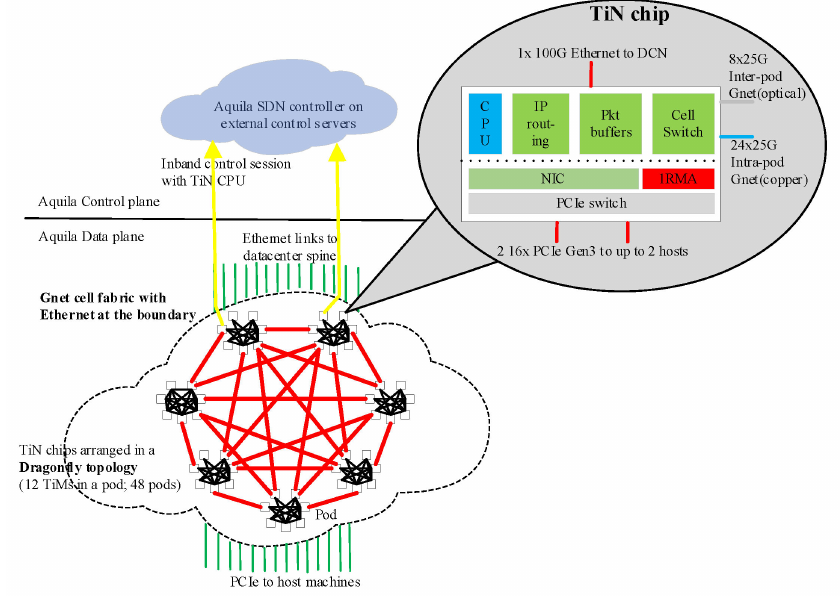
Figure 3. The overview of